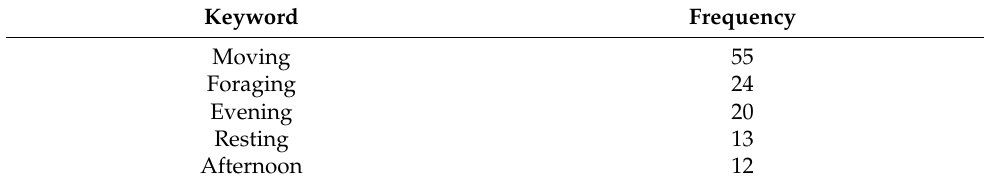
Table 5. Top 5 high-frequency